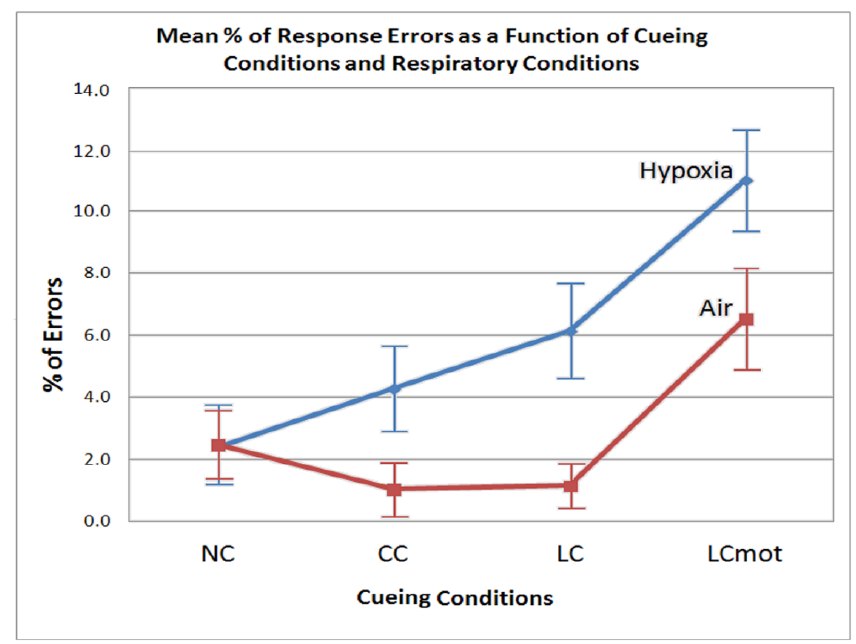
Figure 3. Mean percentages (along with standard errors (SE)) of errors committed by participants as a function of cueing condition and respiratory condition regardless of the target strings congruency.